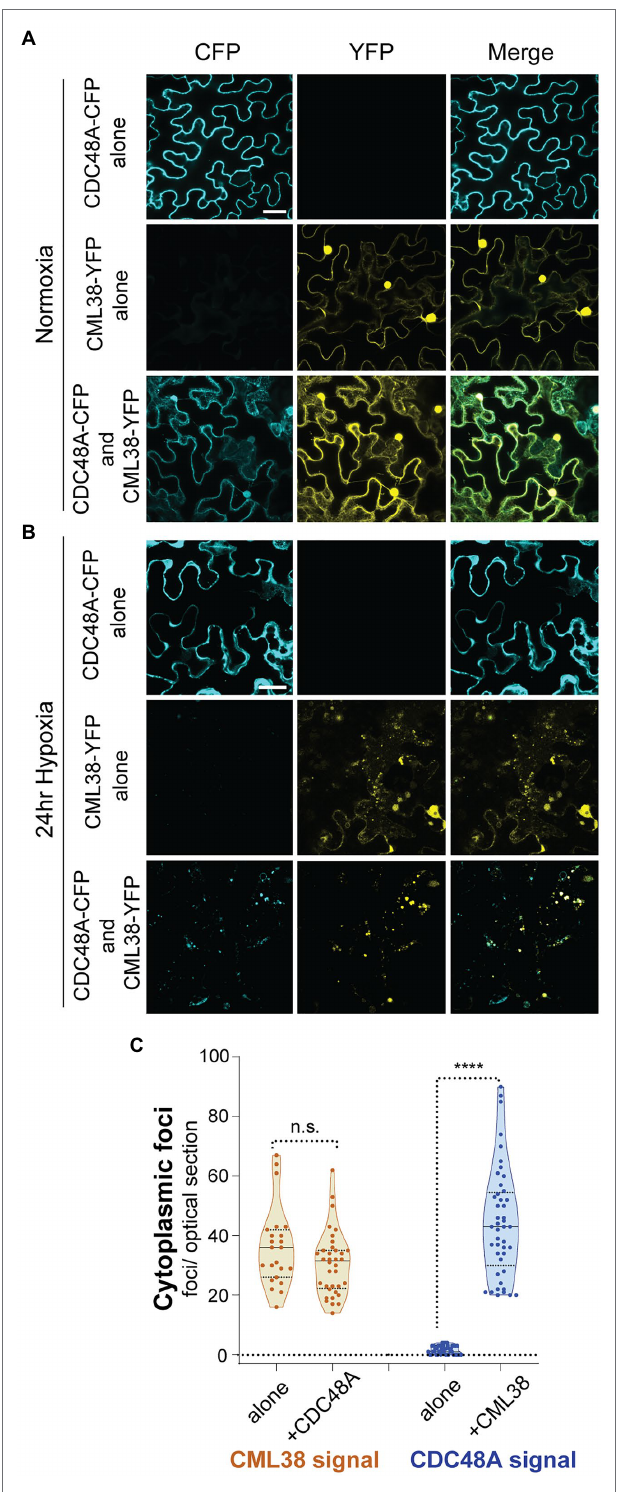
FIGURE 8 | CML38 localizes CDC48A to hypoxia-induced foci in N. benthamiana . Representative confocal micrographs of N. benthamiana leaves transfected with CML38-YFP, CDC48A-CFP, or both proteins. Leaf sections were visualized 48 h after infiltration. (A) Normoxic leaf